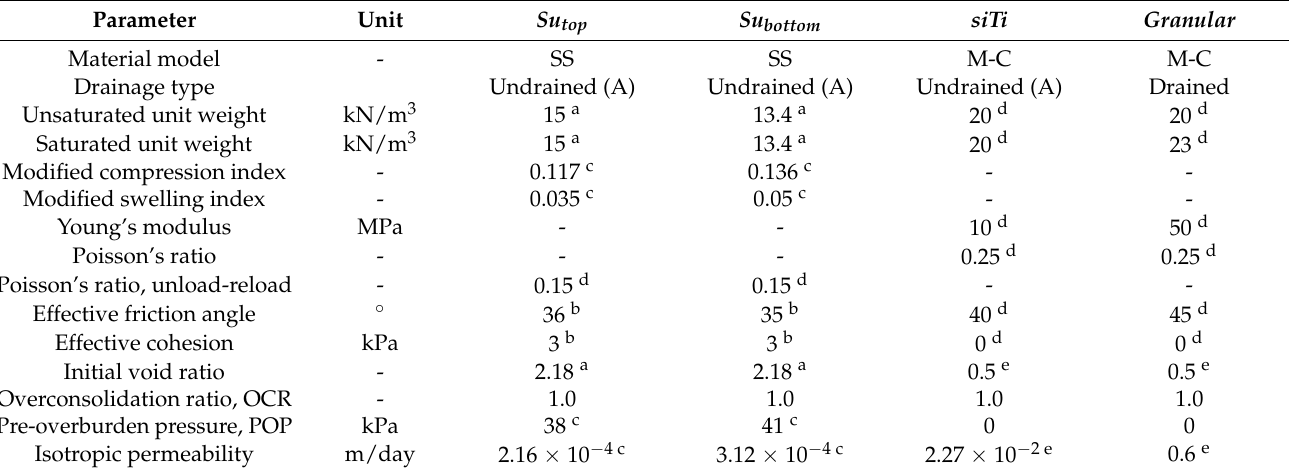
Table 2. Values of soil material